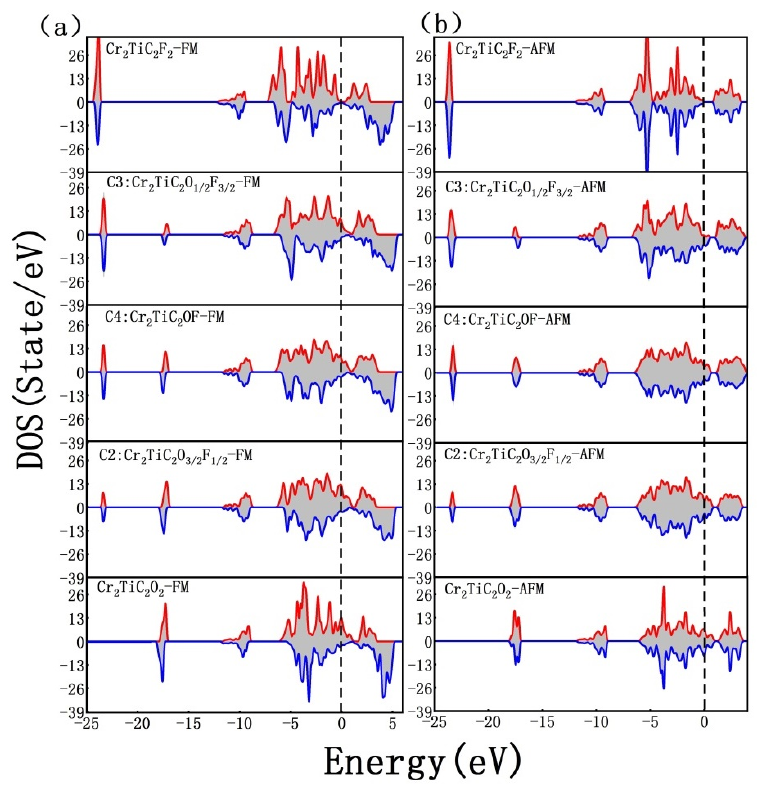
Figure 4. ( a ) Total density of states for FM Cr 2 TiC 2 F 2 , Cr 2 TiC 2 O 1/2 F 3/2 (C3), Cr 2 TiC 2 OF (C4), Cr 2 TiC 2 O 3/2 F 1/2 (C2), and Cr 2 TiC 2 O 2 . ( b ) The corresponding total density of states for AFM1 with same structures in panel (a). The configurations with the lowest energy were used here.